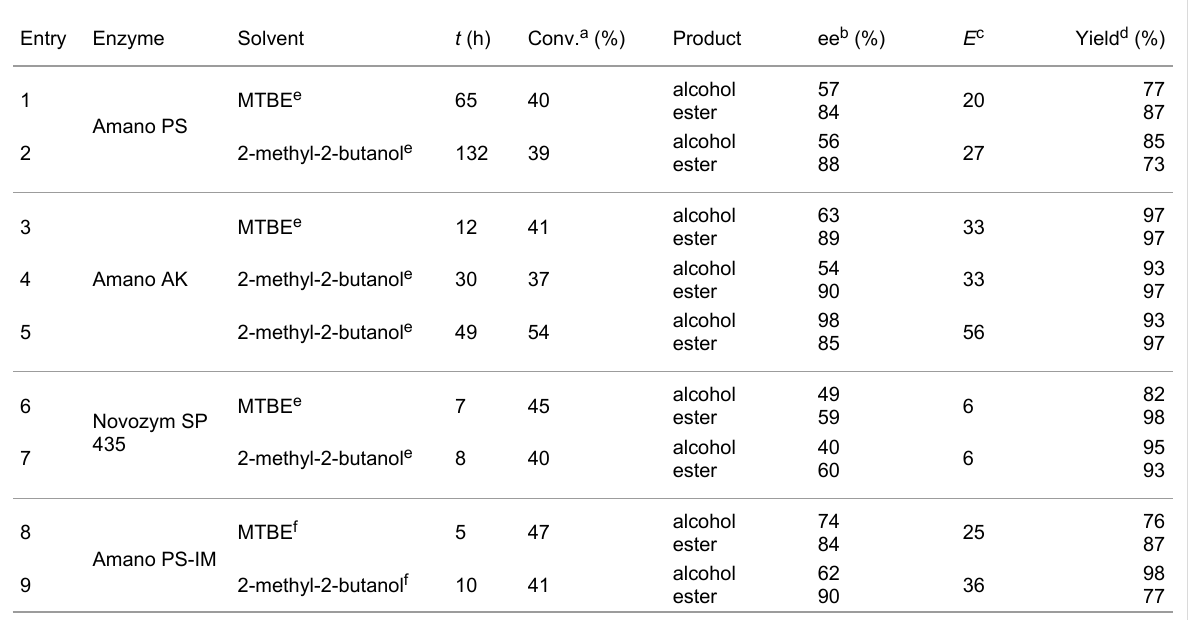
Table 2: Lipase-catalyzed resolution of racemic 1-(1 H -1,2,4-triazol-1-yl)propan-2-ol (±)- 3b .